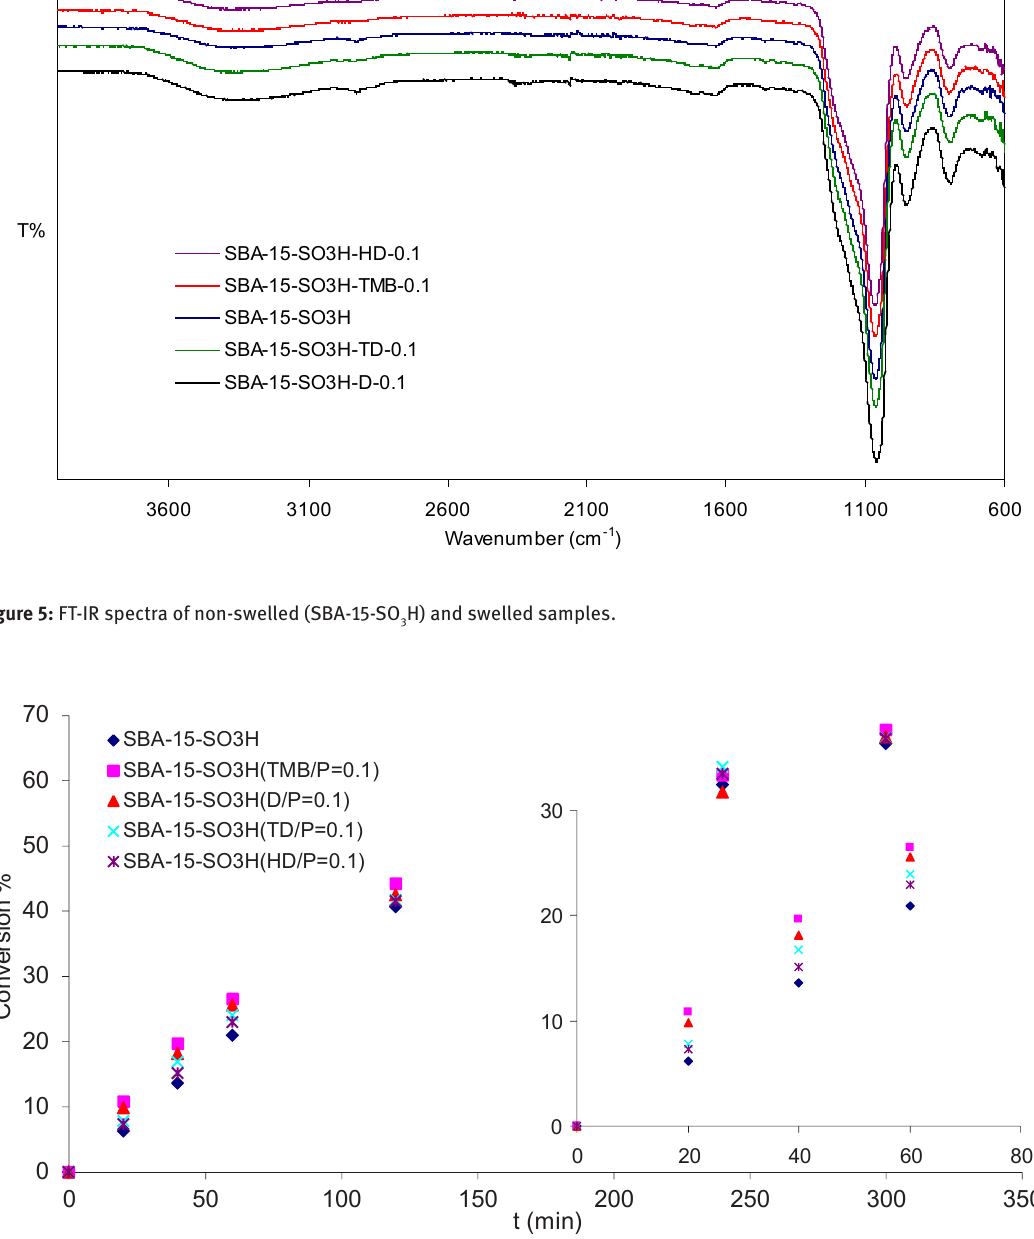
Figure 6: Conversion of propionic acid versus time (propionic acid/ methanol molar ratio: 1/1, stirring rate: 500 rpm, temperature: 60 o C, catalyst: 0.5 g, solvent: 1,4-dioxane)-(early stage of reaction is given in